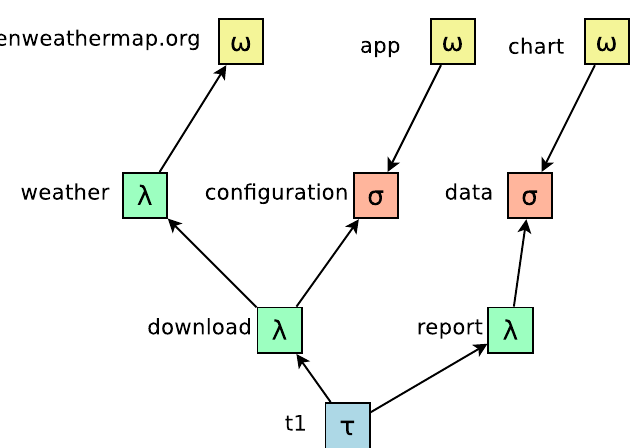
Figure 4. The functional modules that implement the prototype solution for the use